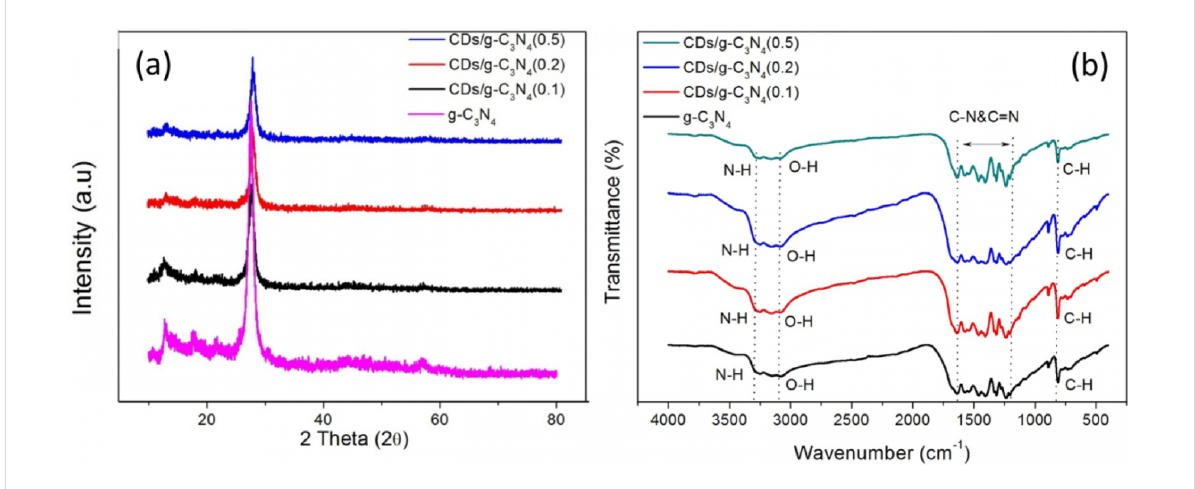
Figure 2: (a) XRD patterns and (b) FTIR spectra of g-C 3 N 4 , CD/g-C 3 N 4 (0.1), CD/g-C 3 N 4 (0.2), and CD/g-C 3 N 4 (0.5).